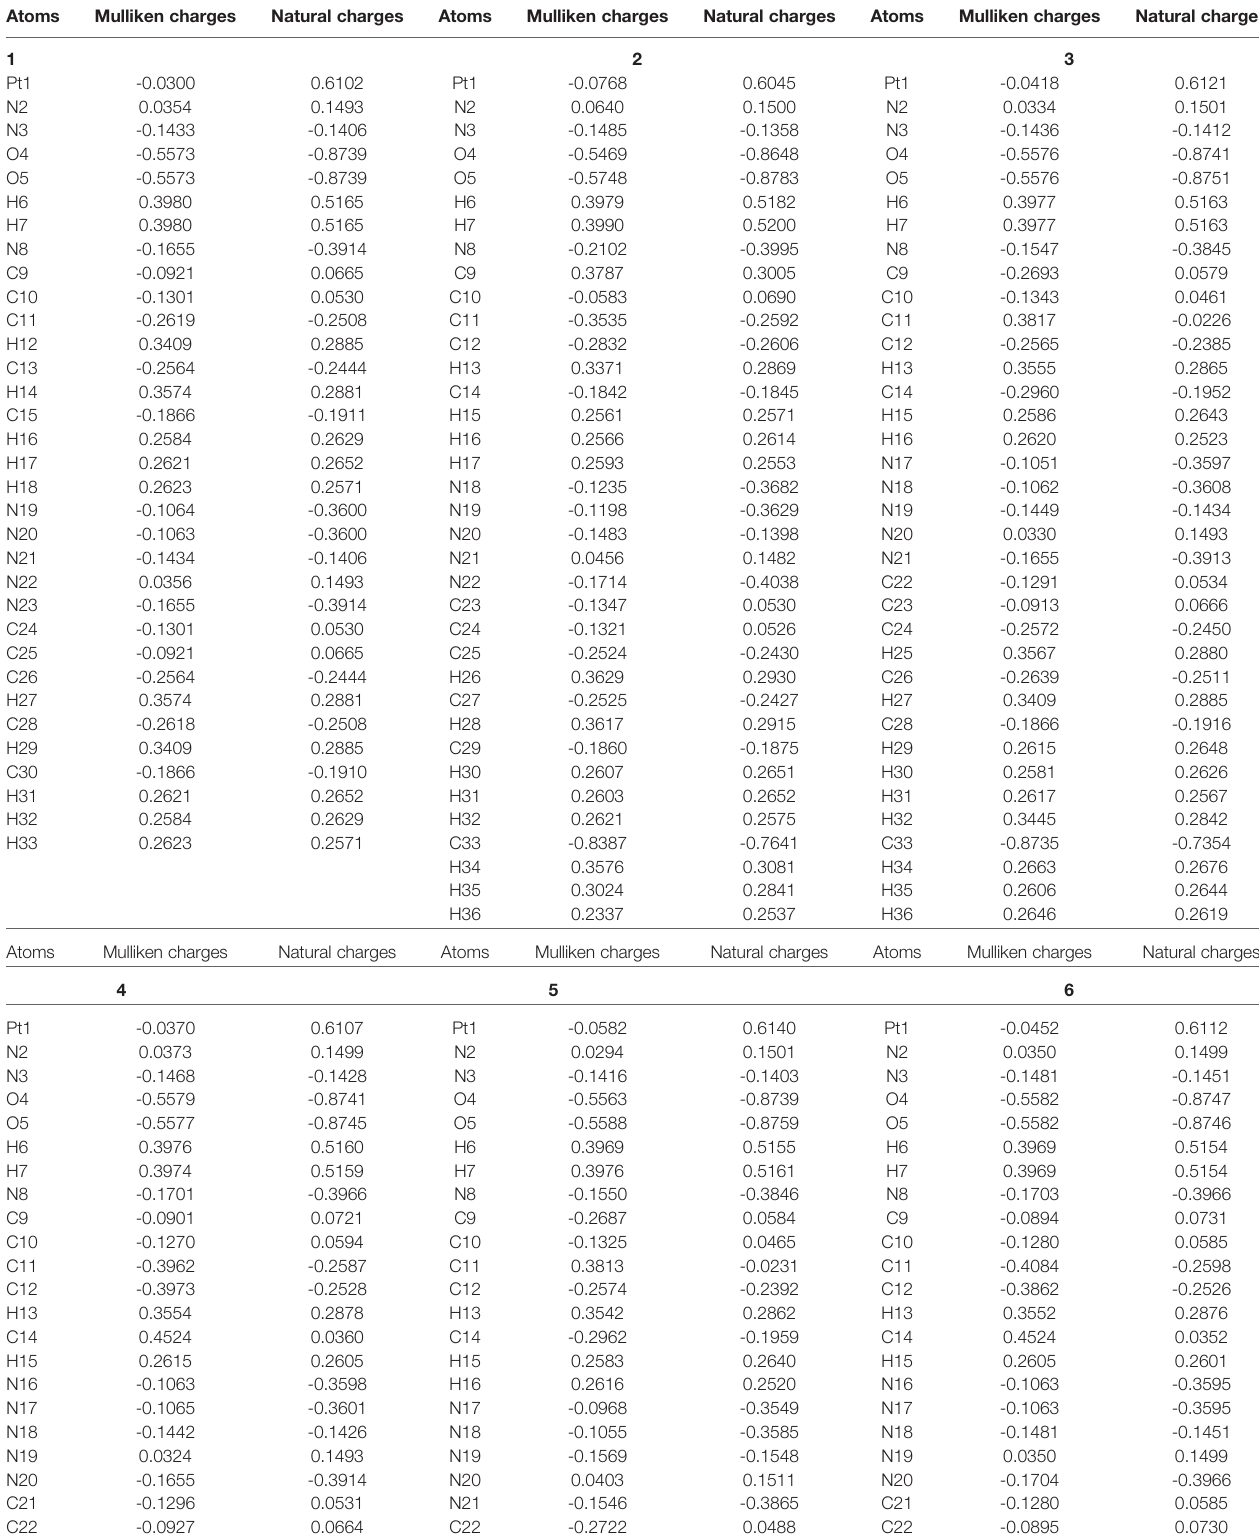
TABLE 5 | The calculated Mulliken charges and natural atomic charges of compounds 1, 2, 3, 4, 5 and